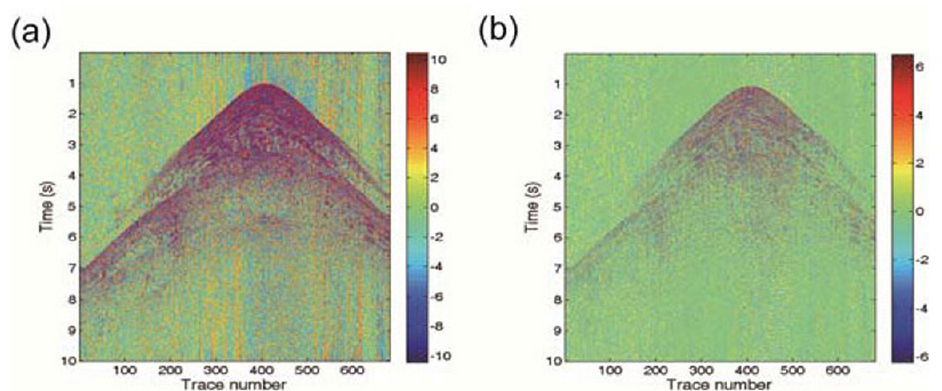
Fig. 9. OBS field data after harmonic noise removal. (a) Result of applying the harmonic noise removing method without the aid of logarithmic transform. Components IMF-4 to IMF-9 were determined as noise and eliminated. (b) Result of applying the harmonic noise removing method to data with logarithmic transform in which components IMF-6 to IMF-9 were determined as noise and eliminated. The amplitudes shown in both figures are on the logarithmic